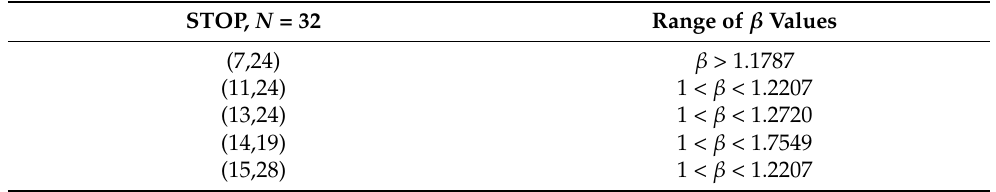
Table 3. Range of β values when N =